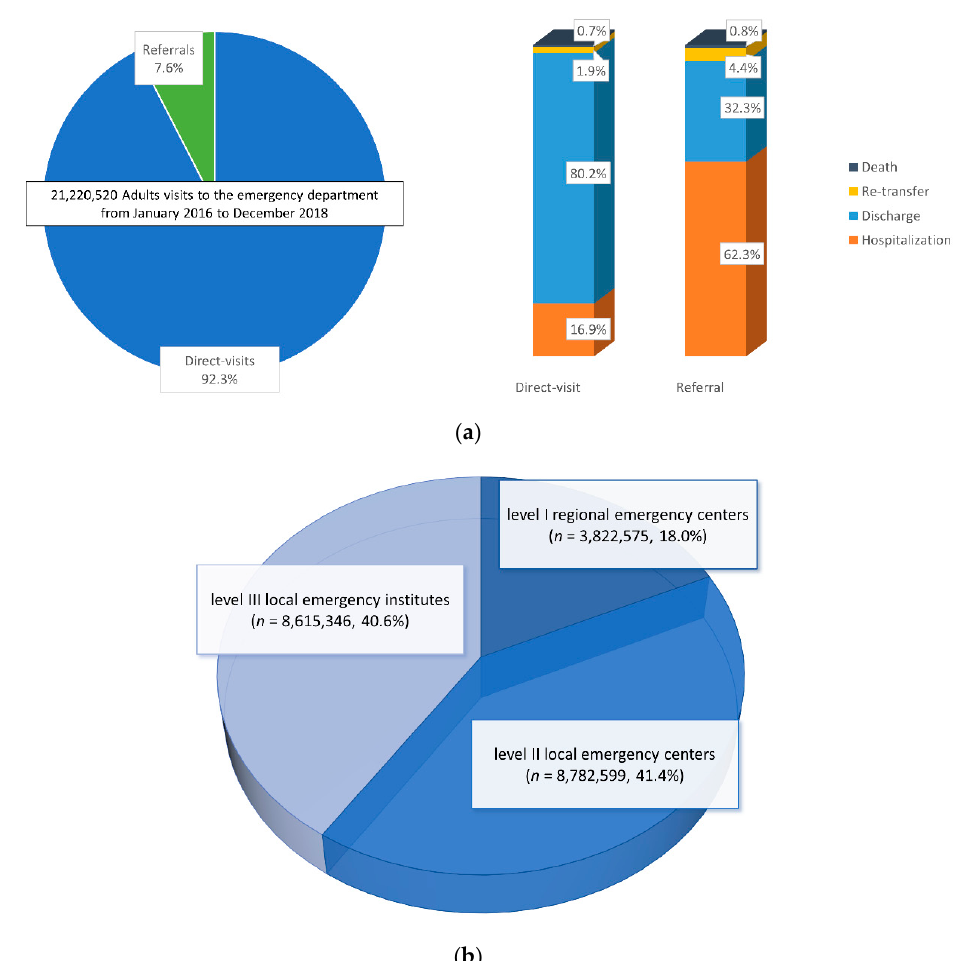
Figure 1. ( a ) Composition of adult emergency department (ED) visits from 2016 to 2018 by the route of visit. The ED dispositions are presented in the right 100% stacked-bar graph, comparing the direct-visit group with the referral group. ( b ) The proportion of ED visits by the level of ED is presented.